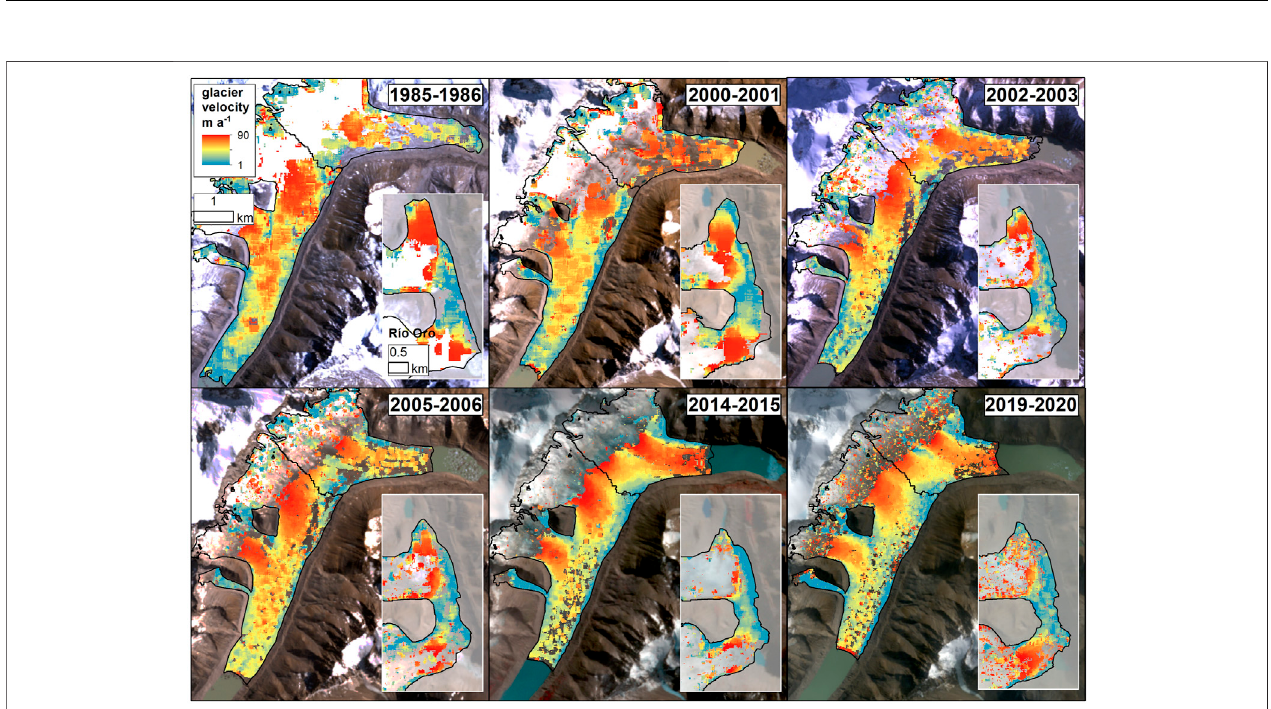
FIGURE 4 | Examples of glacier fl ow velocity maps selected for six survey